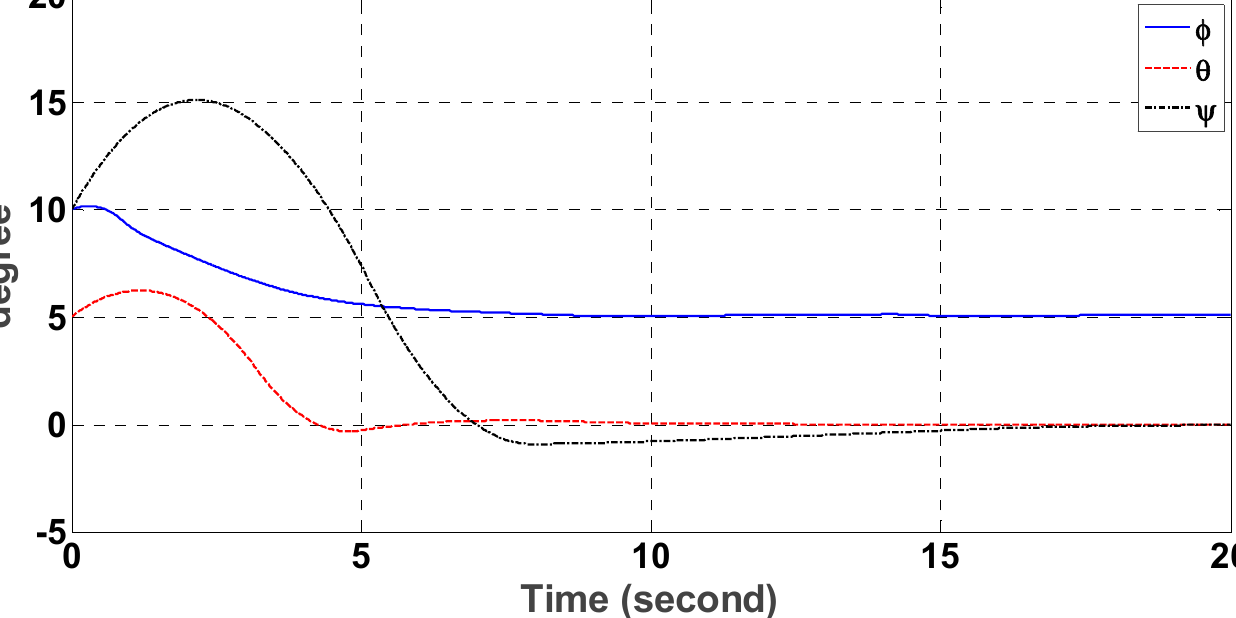
Figure 11. Euler angles time history using a PWPF modulator.